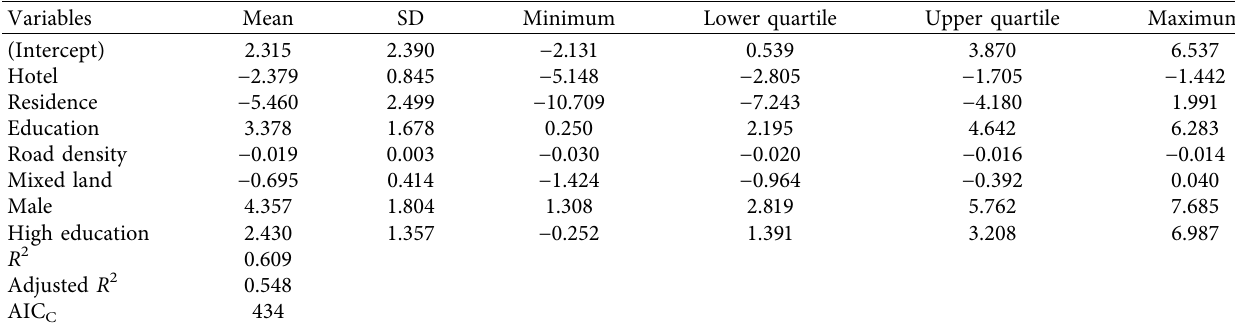
Table 8: Regression results of GWR_Access.